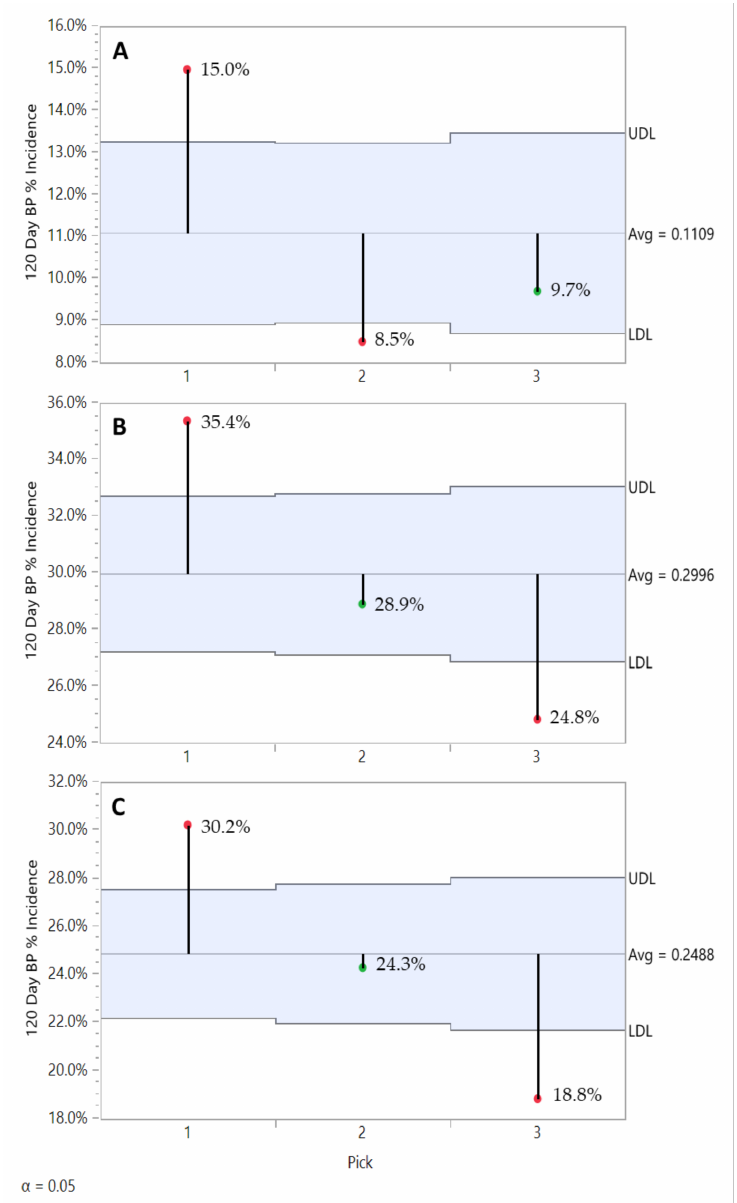
Figure 7. Pick timing effect on B.9 ( A ), M.26 ( B ), and M.9 Clone ( C ) ‘Honeycrisp’ orchards bitter pit incidence after 120 days of refrigerated storage with all years and regions combined. JMP Fit XY Platform, Analysis of Means of Proportions of the binomial dataset, alpha =